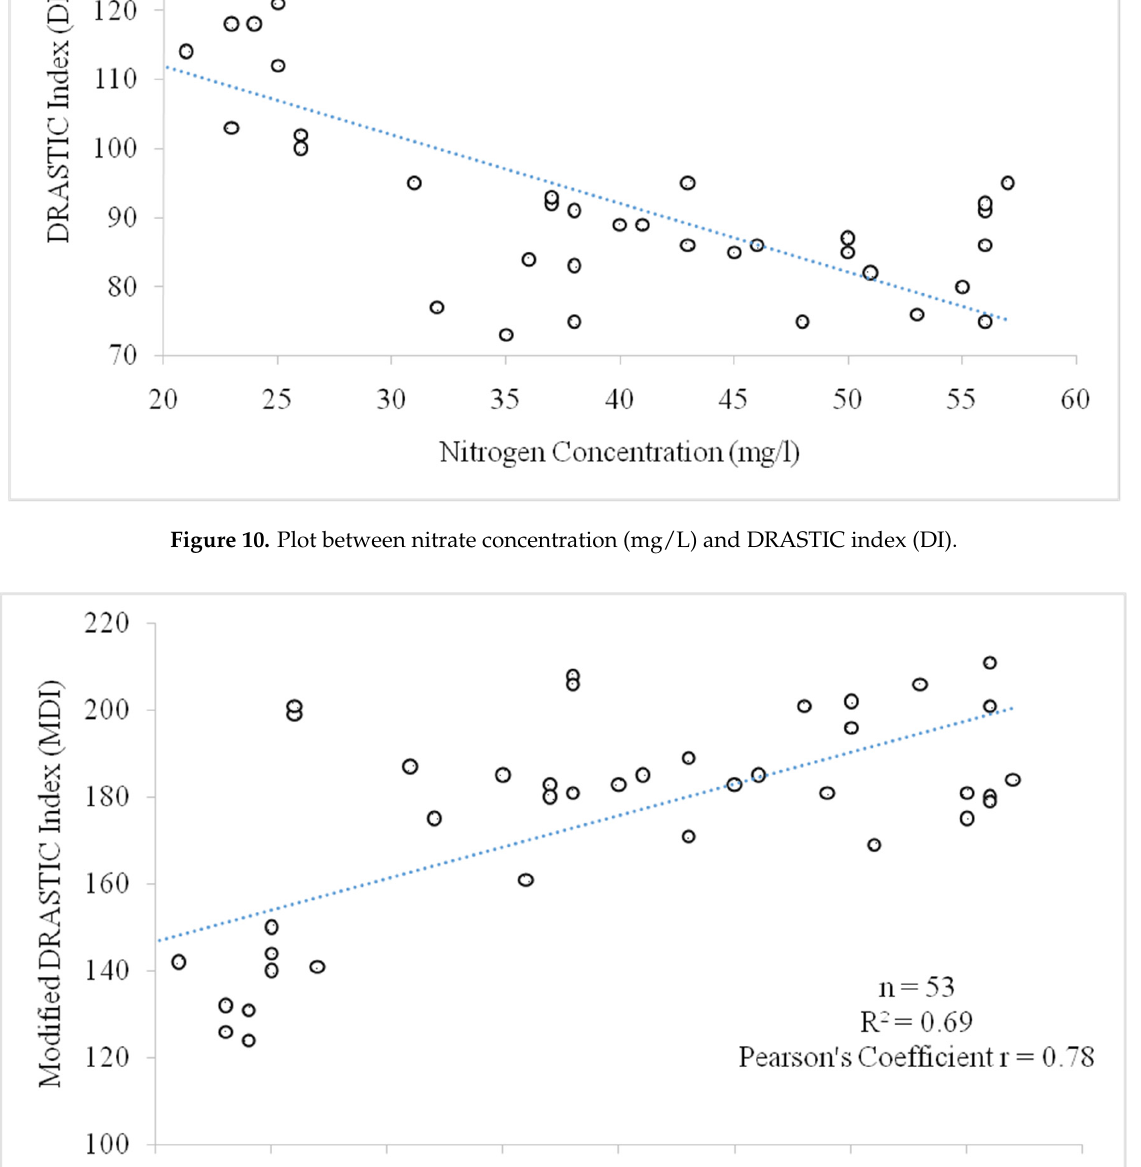
Figure 11. Plot between nitrate concentration (mg/L) and modified DRASTIC index (MDI).